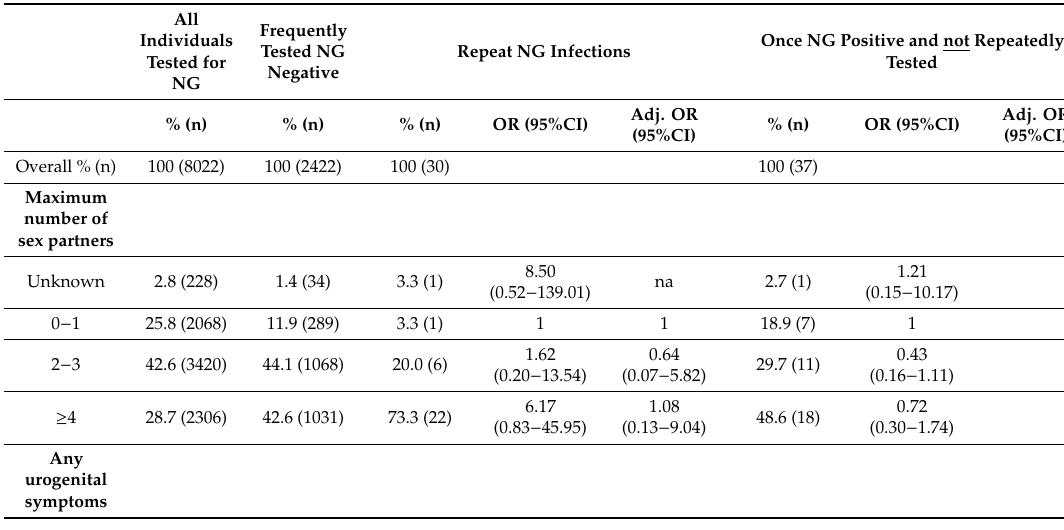
Table 2. Secondary analyses among only the STI clinic population tested for NG between January 2011 and July 2018 including determinants associated with “repeat NG infections”, and “once NG